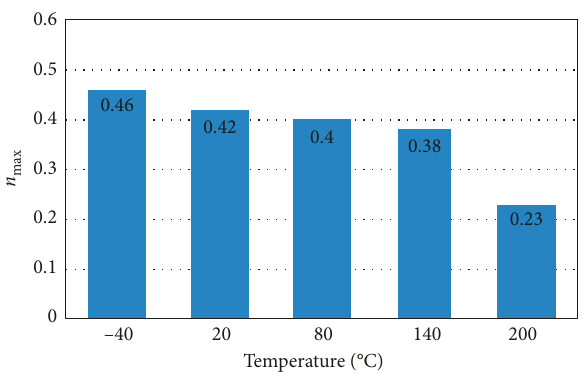
Figure 7: Maximum values of work-hardening exponent n various tensile test